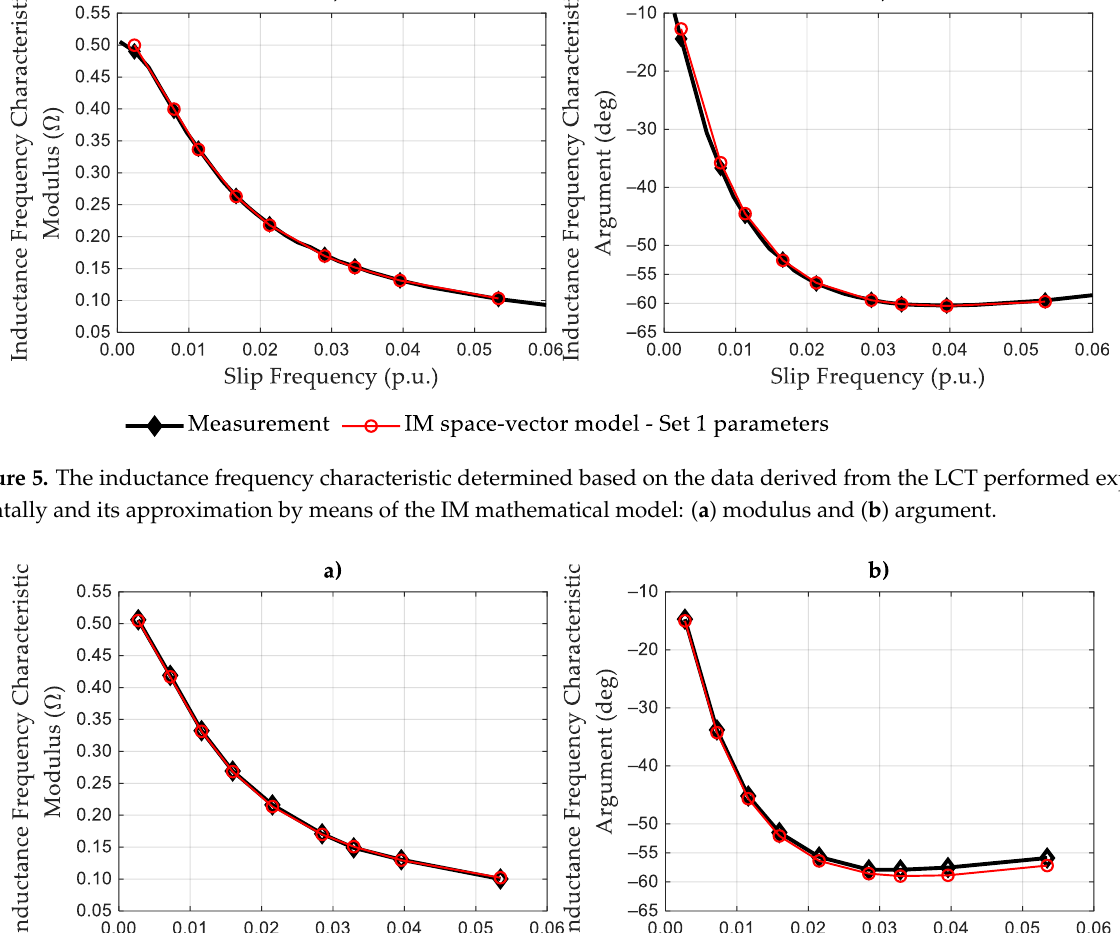
Table 5. Electromagnetic parameters of the IM equivalent circuit with two ( N = 2) parallel con- nected two-terminals in the rotor network representation. The resistances correspond to the refer- ence winding temperature of 25 °C.